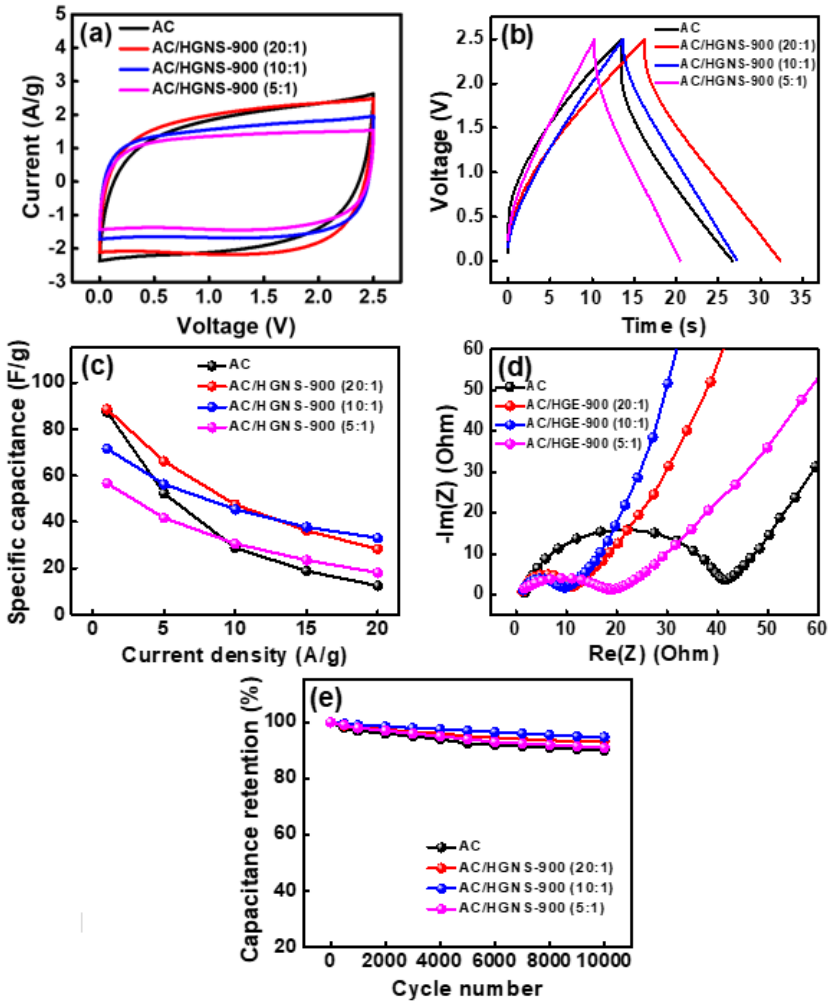
Figure 6. ( a ) CV curves of various cells measured at potential sweep rate of 50 mV · s − 1 ; ( b ) Galvanostatic charge–discharge curves of various cells measured at 5 A · g − 1 ; ( c ) Specific capacitances of various electrodes at di ff erent current densities; ( d ) EIS Nyquists plots and ( e ) cycling stability data of various cells.